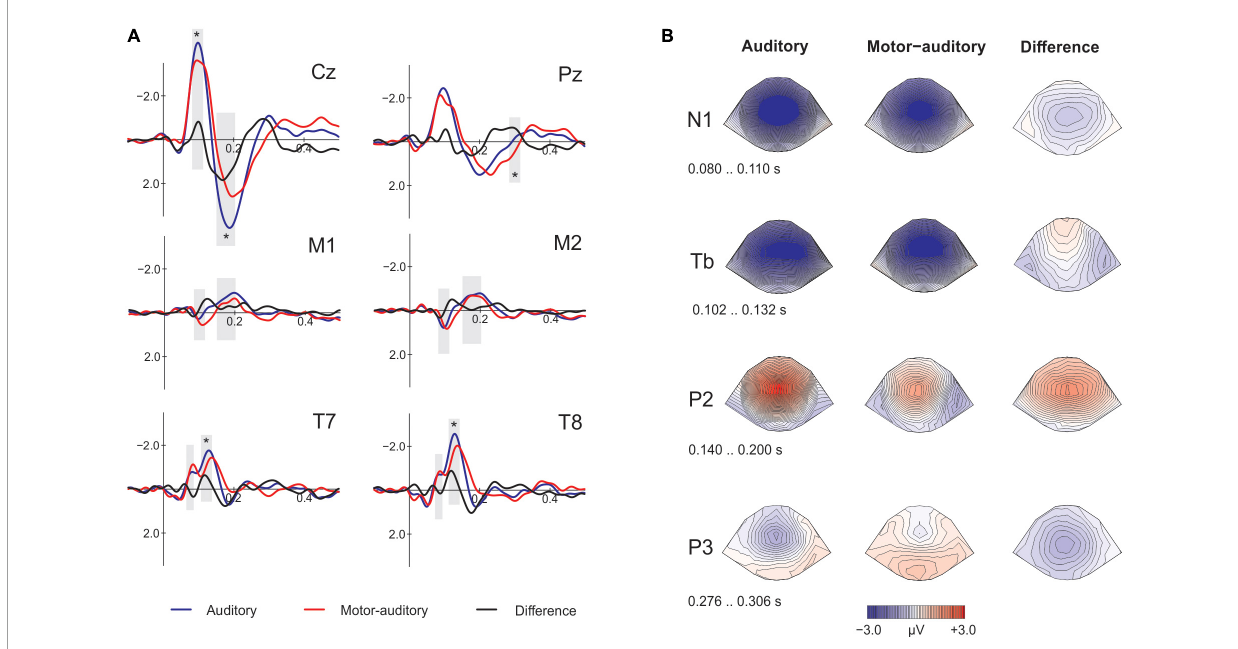
FIGURE2 Electrophysiological results comparing the auditory and motor-auditory (motor corrected) stimuli at encoding. (A) Event-related-potentials (ERPs) on the analyzed electrodes. At Cz, M1 and M2 the analyzed components are N1 and P2, at T7 and T8 the N1 subcomponents Na and Tb, and at Pz the P3 component. The gray shading marks the time windows of the amplitude analysis. Asterisks mark significance. (B) Topographical plots of each component of